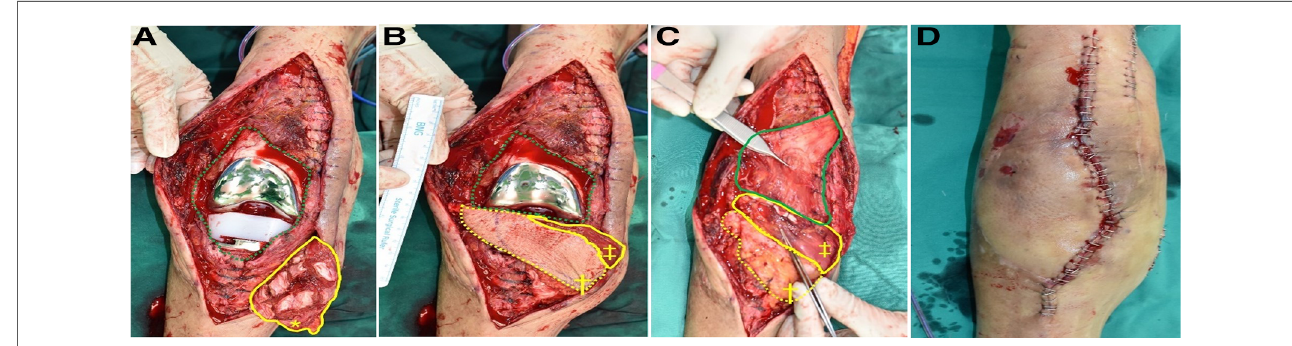
FIGURE 1 Intraoperative photographs. ( A ) 11 cm×6 cm sized capsule defect (green dotted line), scored gastrocnemius muscle fascia (yellow bold line). ( B ) Gastrocnemius musculocutaneous fl ap covered the lower half. ( C ) Deepithelized skin island (yellow dotted line), the gastrocnemius muscle, and the distally based gracilis (green bold line) covered the defect was and sutured. ( D ) An immediate postoperative appearance after skin closure. ( * , scored gastrocnemius muscle fascia; † , skin island overlying gastrocnemius muscle; ‡ , gastrocnemius